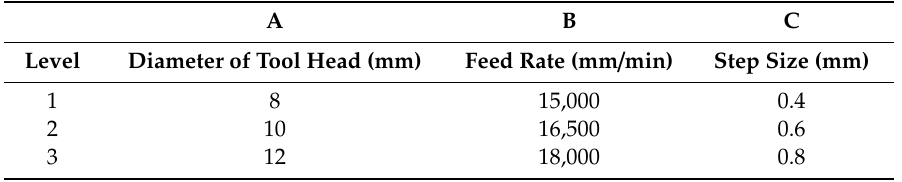
Table 2. Experimental factors and